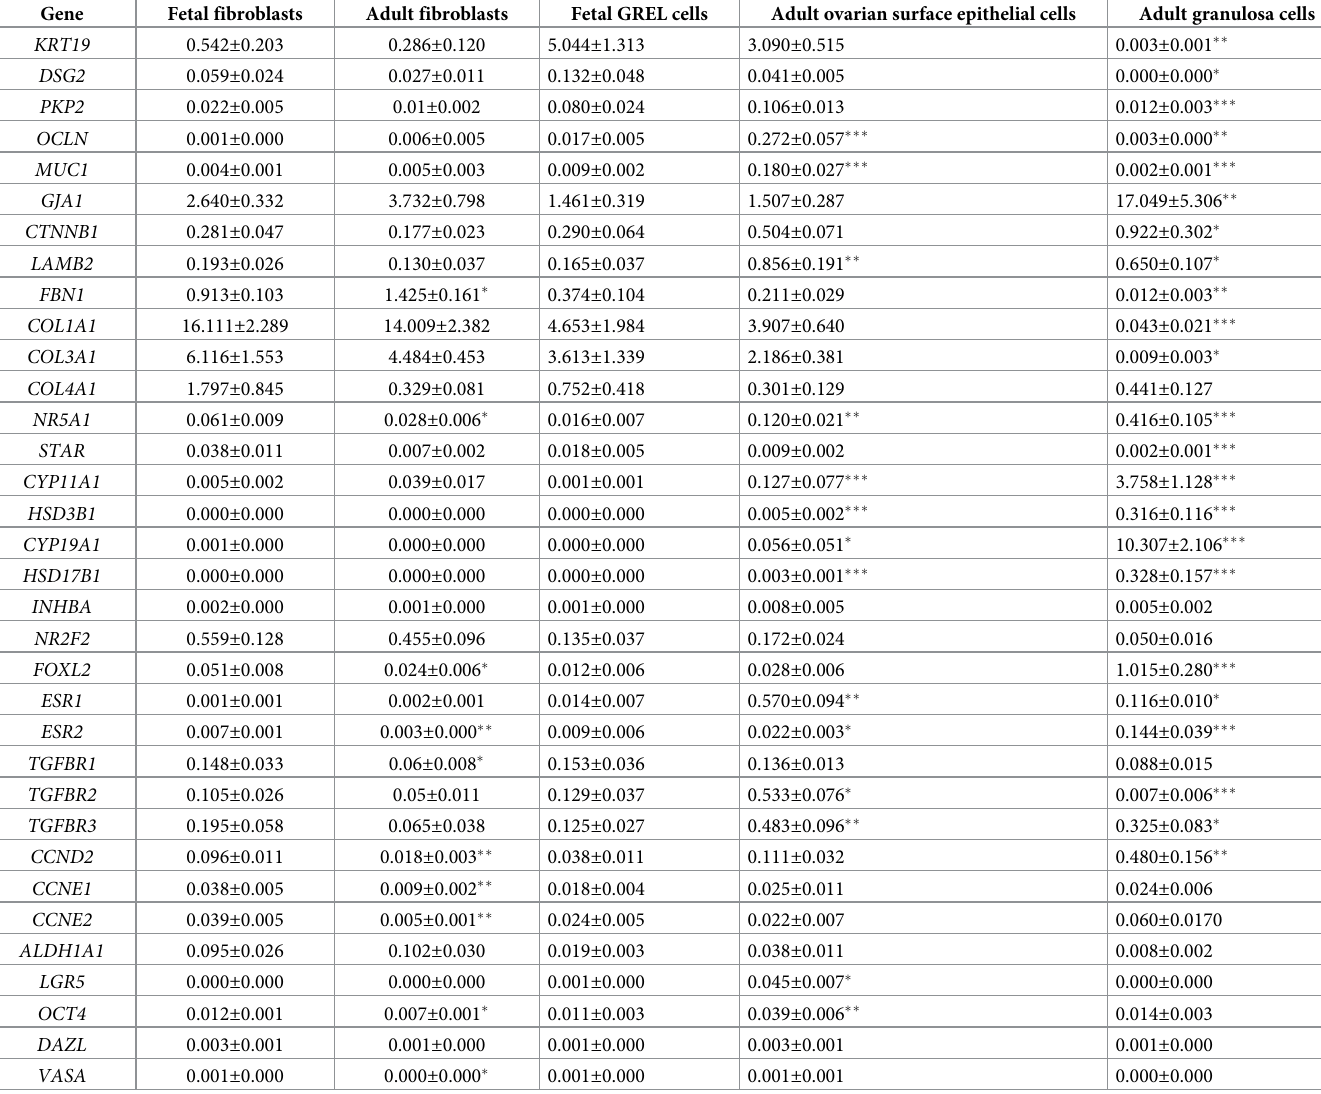
Table 1. Relative gene expression levels (2- Δ Ct) are presented as mean ± SEM for each cell type. Comparisons are between fetal fibroblasts (n = 6) with adult fibro- blasts (n = 4), and then fetal GREL cells (n = 7) with adult ovarian surface epithelial cells (n = 5) or granulosa cells (n = 5). Gene Fetal